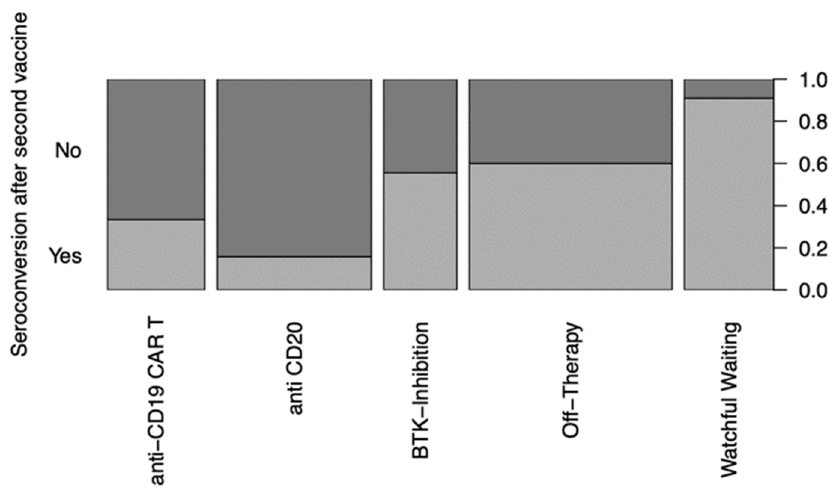
Figure 2. Mosaic plot of seroconversion with a >0.8 BAU/mL after the 2nd vaccination distributed by treatment modality. Anti-CD19 CAR T ( n = 12), anti-CD20 treatment ( n = 19), BTKi ( n = 9), “off-therapy” ( n = 25) and “watchful waiting” ( n = 10).